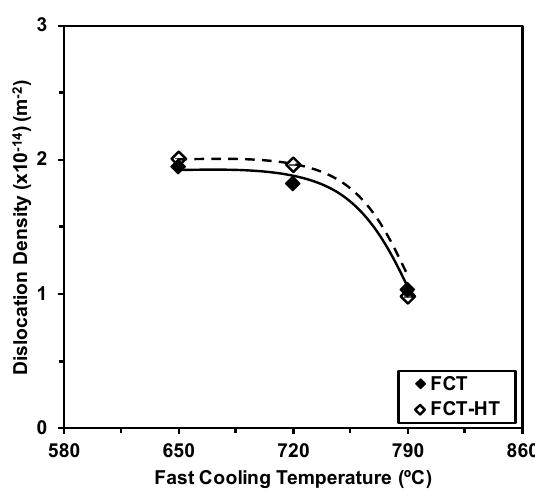
Figure 12. Influence of Fast Cooling Temperatures and induction heat treatment on dislocation density.